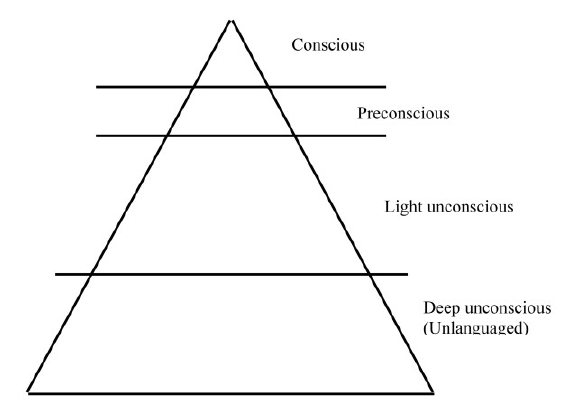
Figure 1: Levels of Human